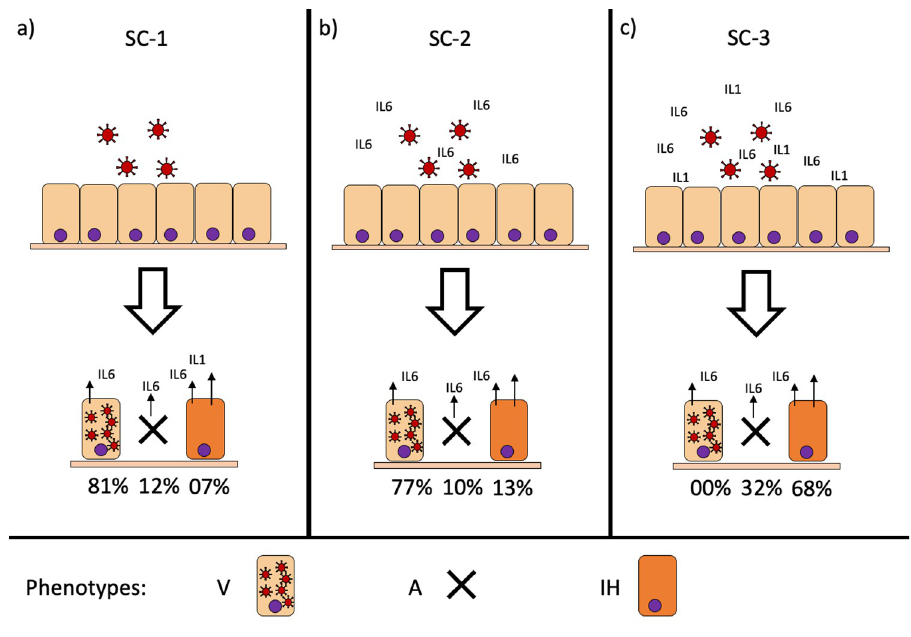
Fig 2. Infection scenarios. A healthy epithelium is exposed to the virus in three different microenvironmental conditions (SC-1, SC-2 and SC-3). Accordingly, to the extracellular cues, healthy cells can evolve into three different phenotypes: viral (V), apoptotic (A), inflammation high (IH) with the relative probabilities reported below (obtained using the GINsim functionality Avatar [36]).